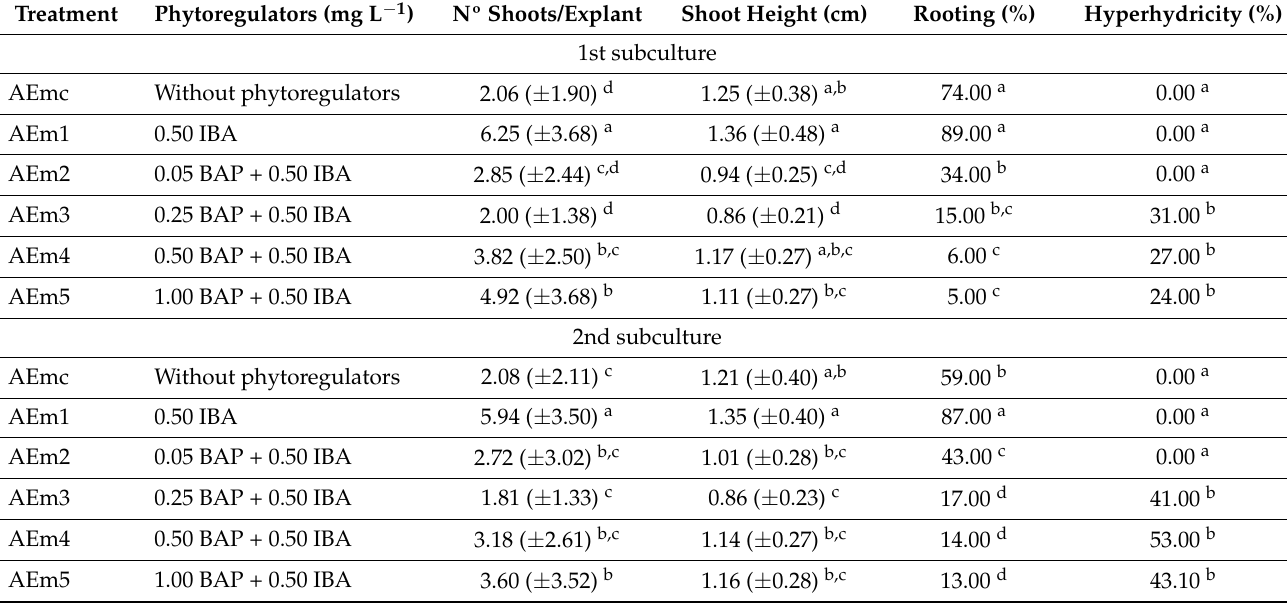
Table 4. Effect of the different multiplication treatments on the growth parameters measured in A. taltalensis shoots after